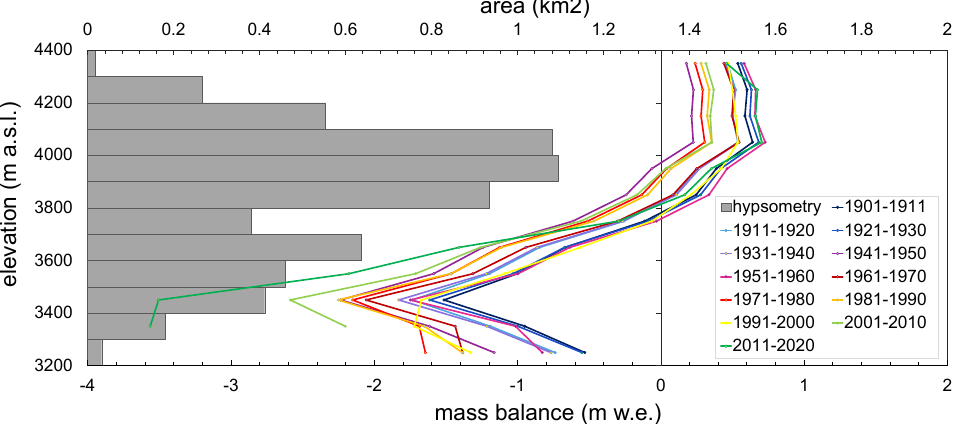
Figure 6. Mass balance gradient with elevation averaged for 10-year periods from 1900 to present. Gray bars showing hypsometry of